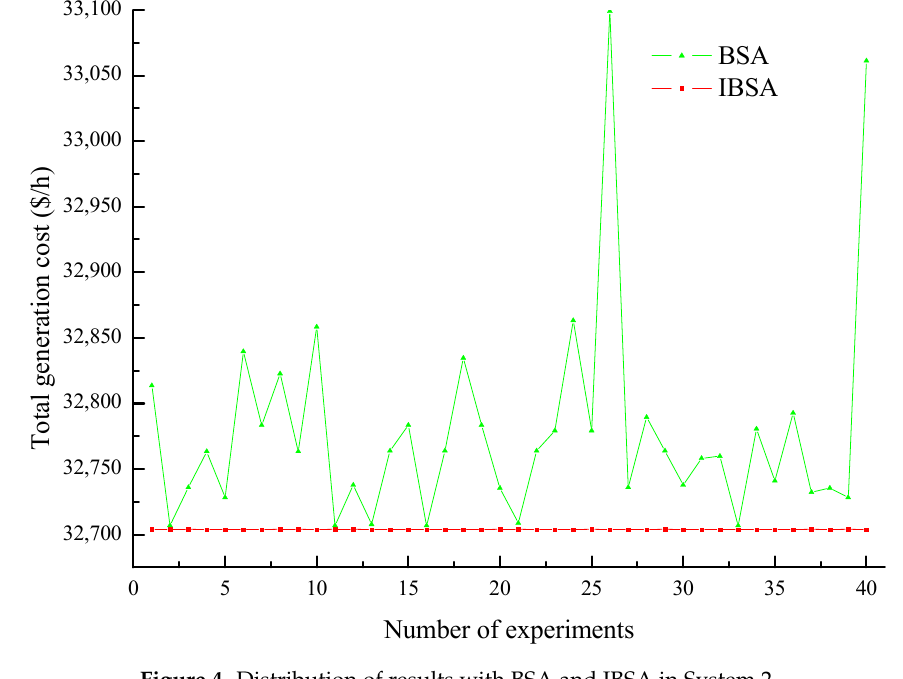
Table 9. Statistical results of multiple methods in System 2.